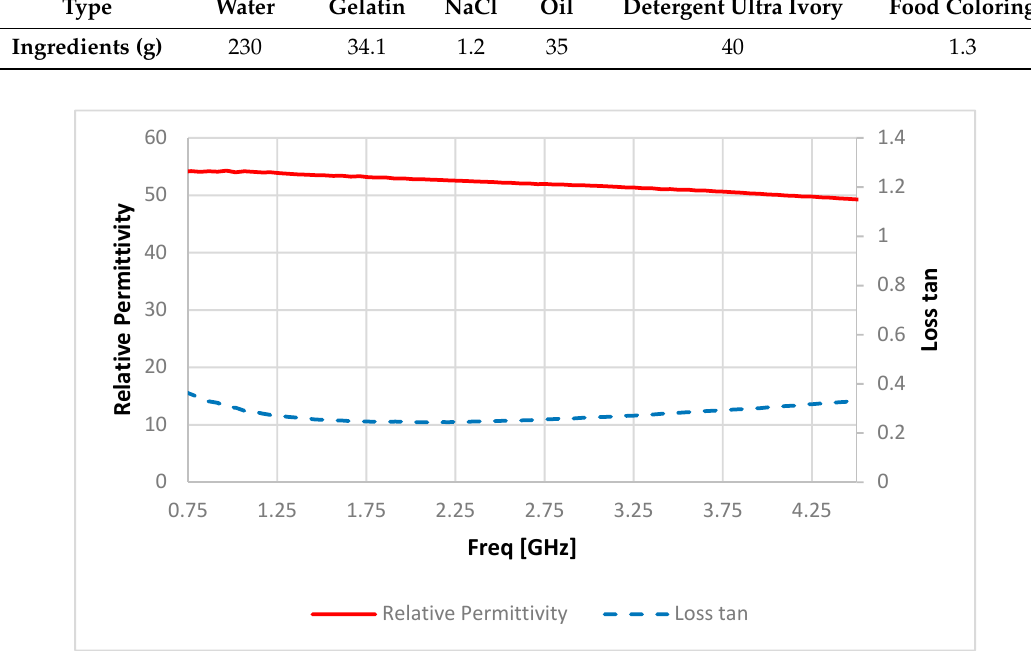
Table A1. Ingredients of muscle tissue-mimicking phantom.